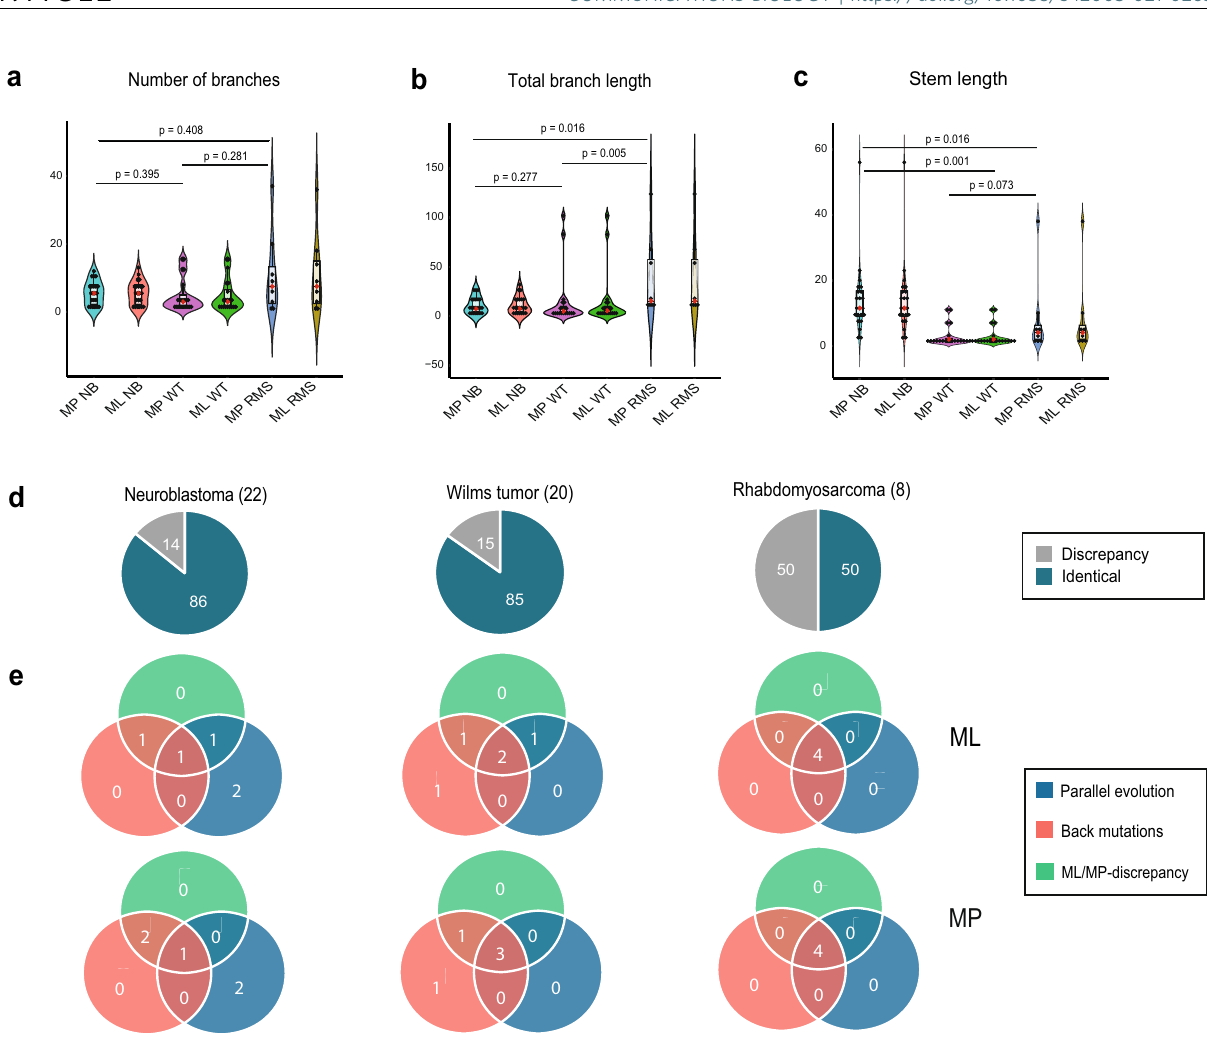
Fig. 3 Structural properties of the generated phylogenetic trees. Violin plots of a the number of branches, b total branch lengths, and c total stem lengths for neuroblastoma (NB), Wilms tumor (WT), and rhabdomyosarcoma (RMS) using either the maximum likelihood (ML) or parsimony (MP) method for phylogenetic reconstruction. Signi fi cance represented by P -values were calculated using the two-sided Mann – Whitney U-test. The box plots within the violin plots illustrates the interquartile range. The red dot is the median value. d In 14% of neuroblastomas, 15% of Wilms tumors, and 50% of the 8 rhabdomyosarcomas analyzed, the phylogenetic trees obtained using the ML and MP methods differed from one another. NB1, NB24, WT1, WT2, WT3, and WT5 are not included in this calculation since they did not display any private genetic alterations. Hence only event matrices could be generated but not phylogenetic trees. If including these cases, the proportions would be 12.8% for NB and 12.5% for WT. e Venn diagrams of how often discrepancies between ML/MP trees, back mutations, and parallel evolution occurred together in the same case/tree. Numbers indicate the number of tumors where a particular contradiction or combination of contradictions occurred. The information used to produce the plots can be found in Supplementary Data 1 and